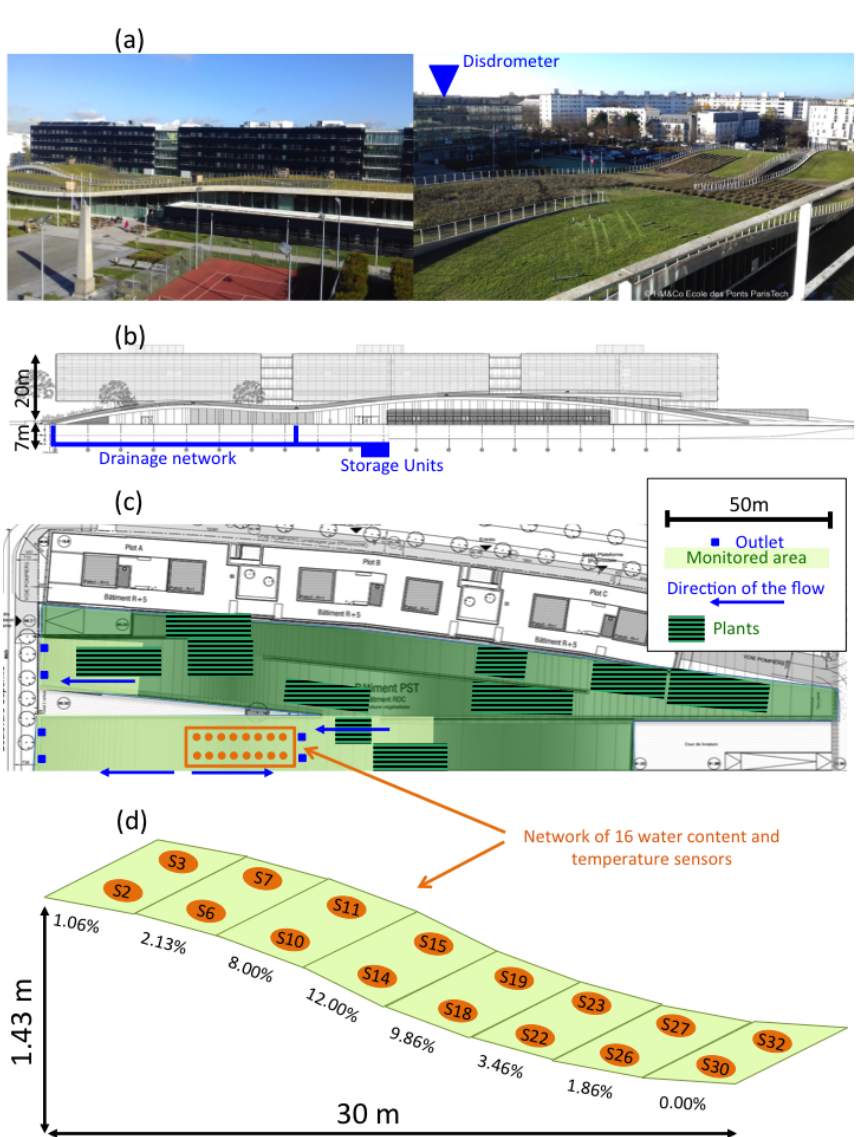
Figure 1. The Blue Green Wave monitoring site of ENPC: (a) pictures, (b) vertical representation and flow path lengths, (c) aerial rep- resentation showing the monitored area, and (d) profile of the section where the water content sensors were implemented indicating the